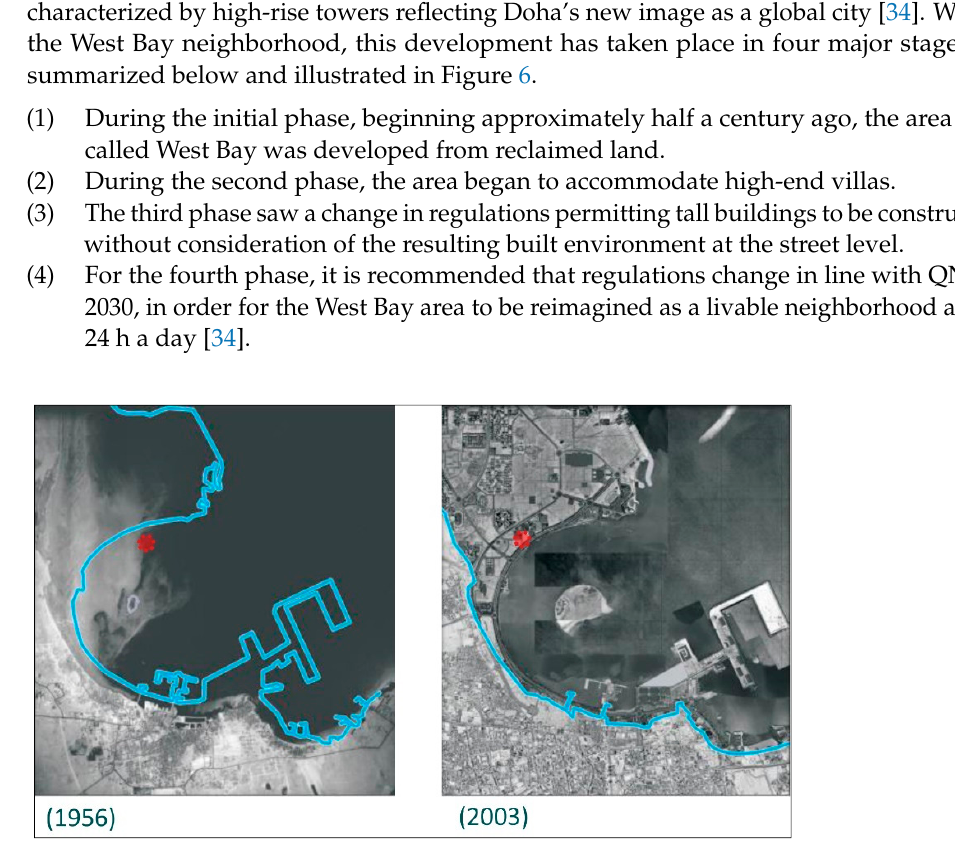
tower height of G + 15 and a minimum setback of 12.5 m [31,34]. Public outdoor